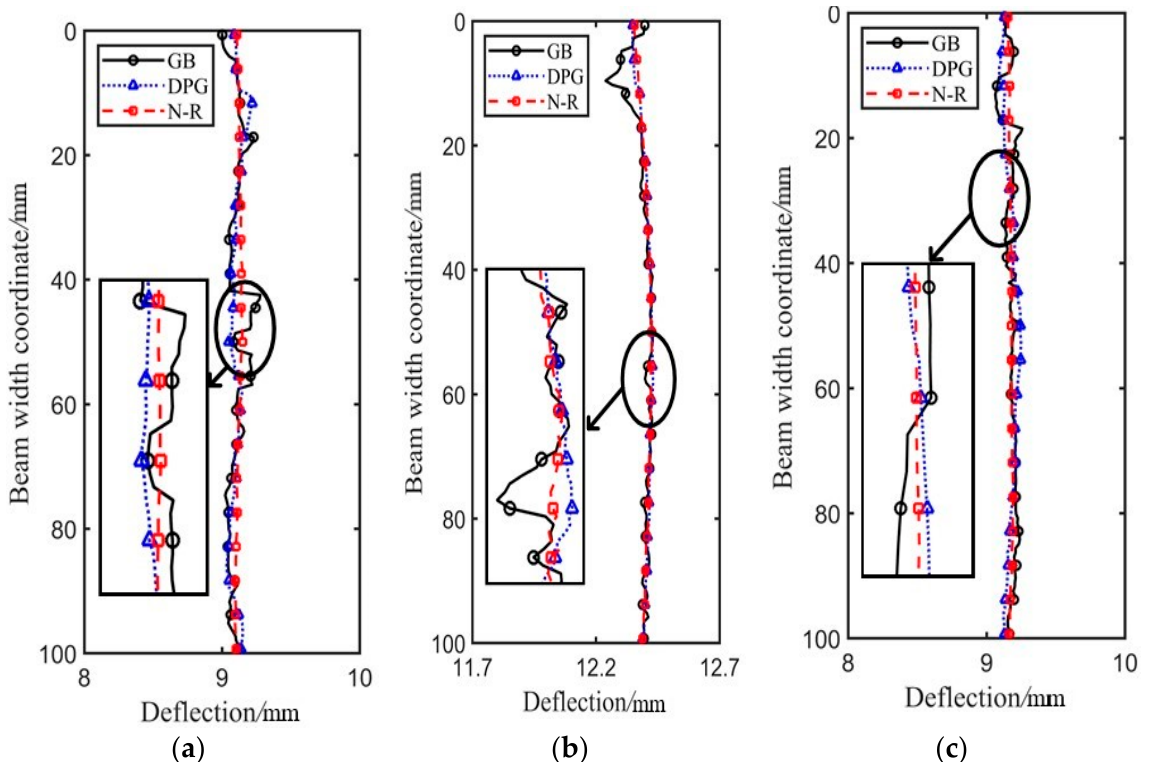
Figure 12. Identification results along the height of beam: ( a ) Micrometer 1; ( b ) Micrometer 2; ( c ) Micrometer 3.